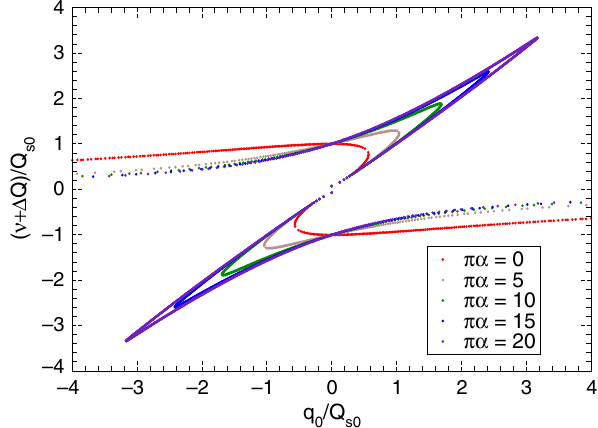
FIG. 9. The lowest real eigennumbers of Eq. (30) at different α .